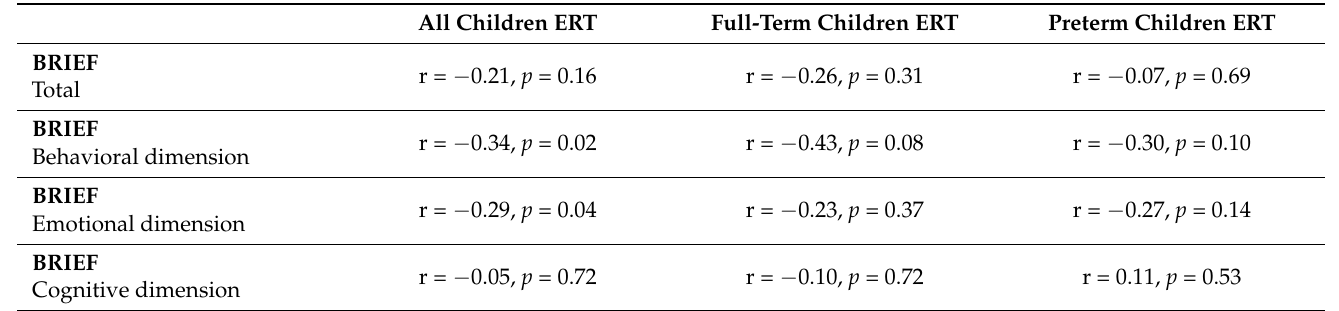
Table 9. Partial correlation between ERT and BRIEF controlling for PSI-Parental Distress.